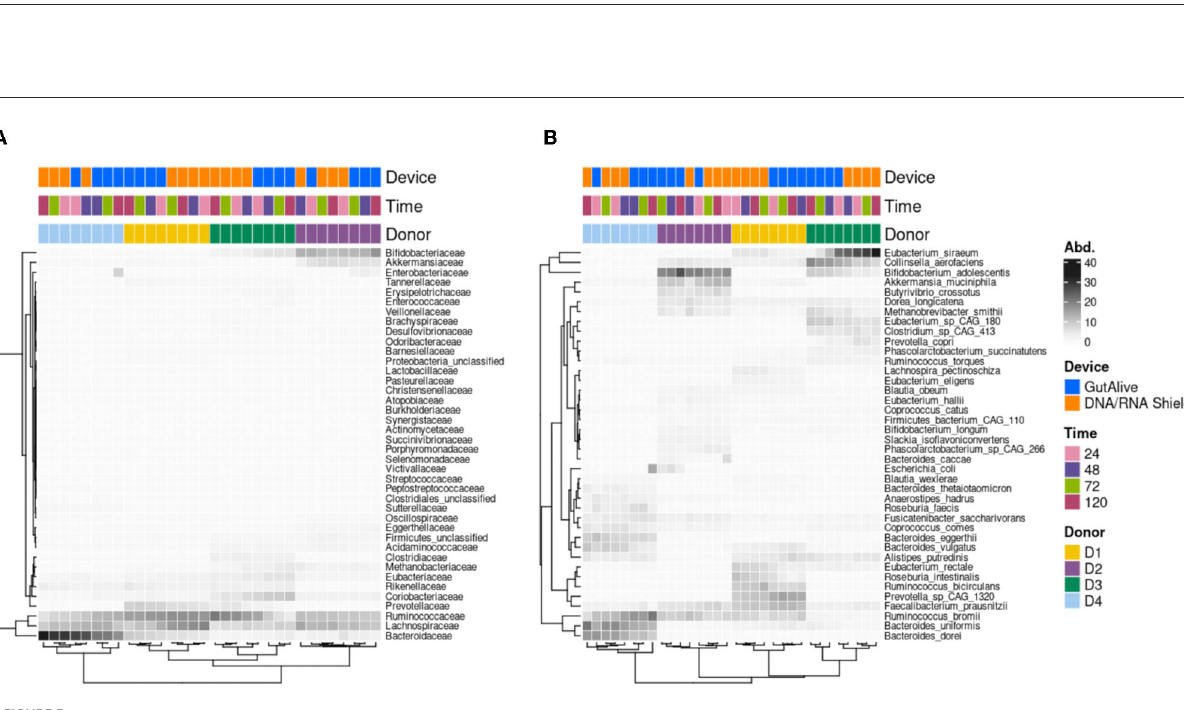
FIGURE3 Heatmap of the abundance of the top 40 taxa. (A) Family level. (B) Species